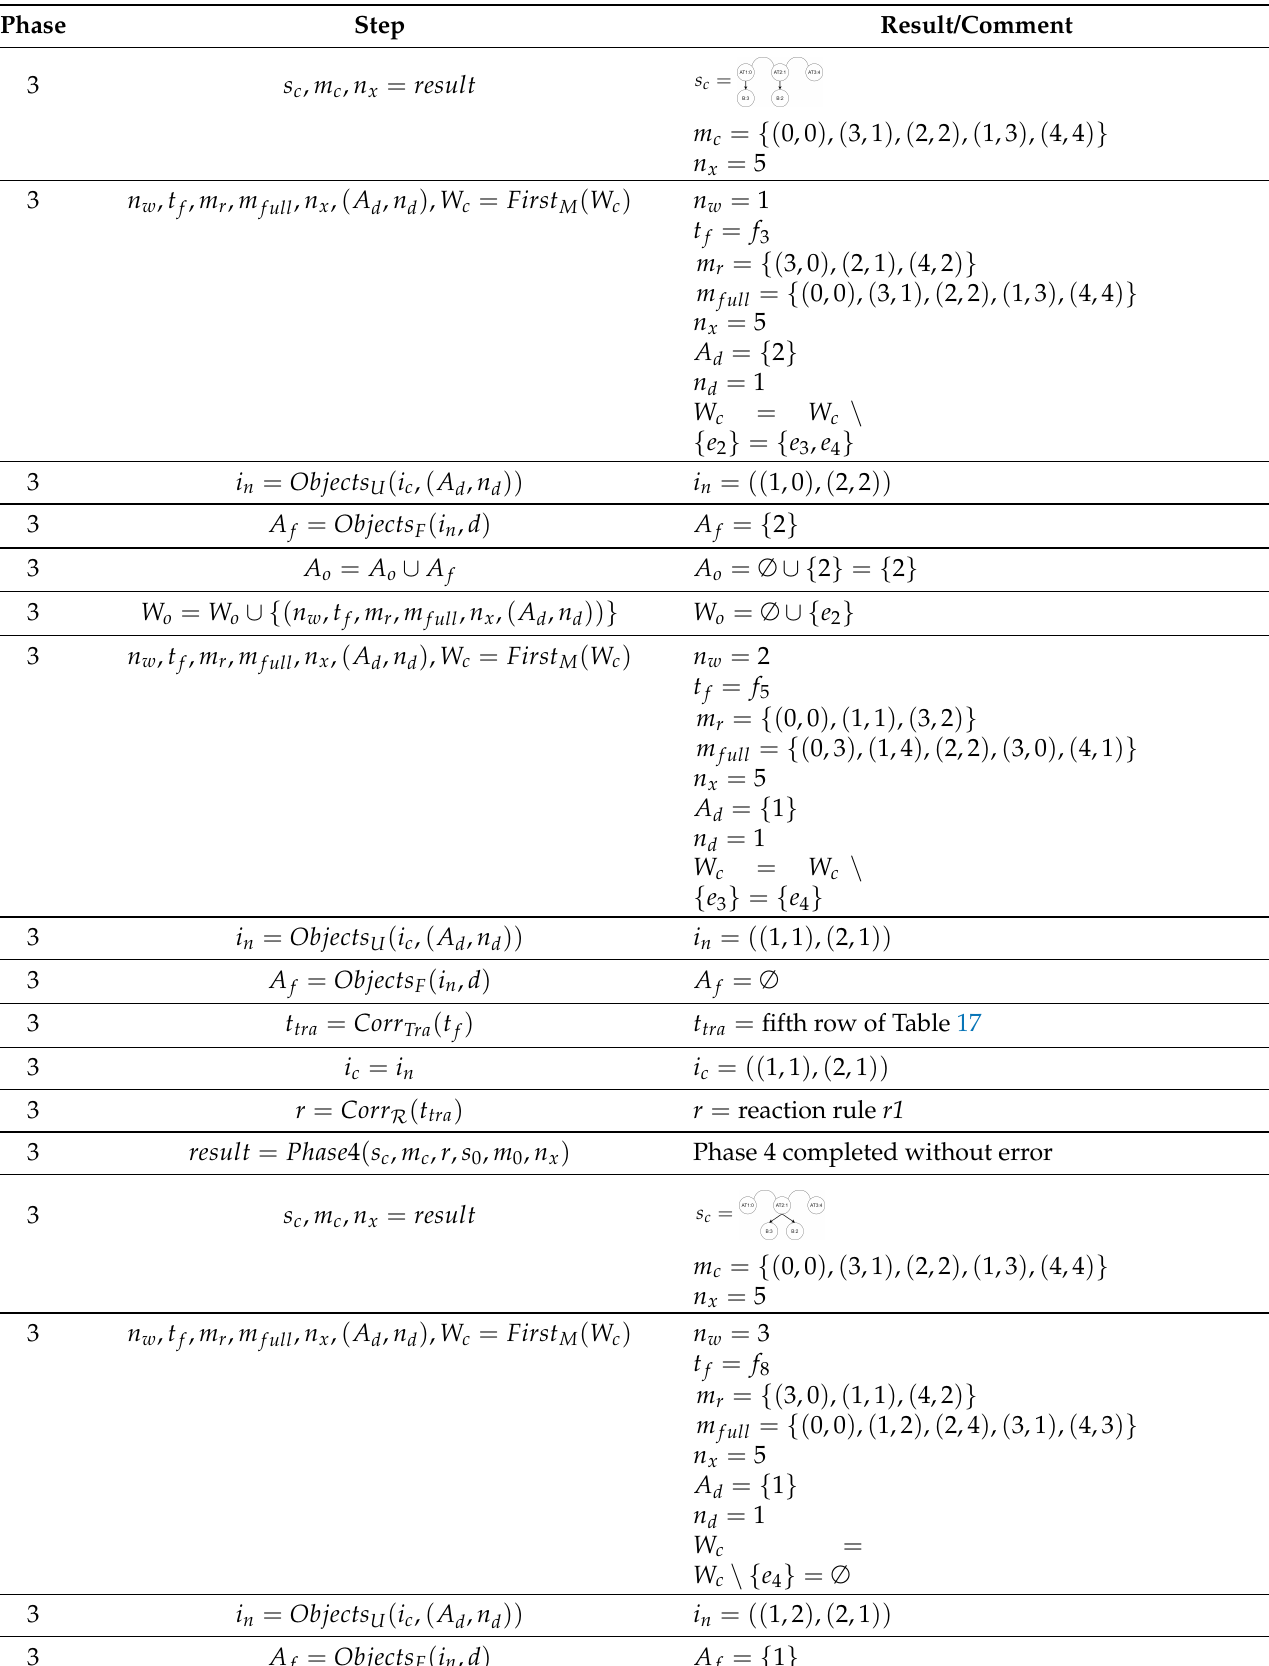
26 of 37 Table 18. Successive steps of the algorithm in the example of visualizing a scenario.